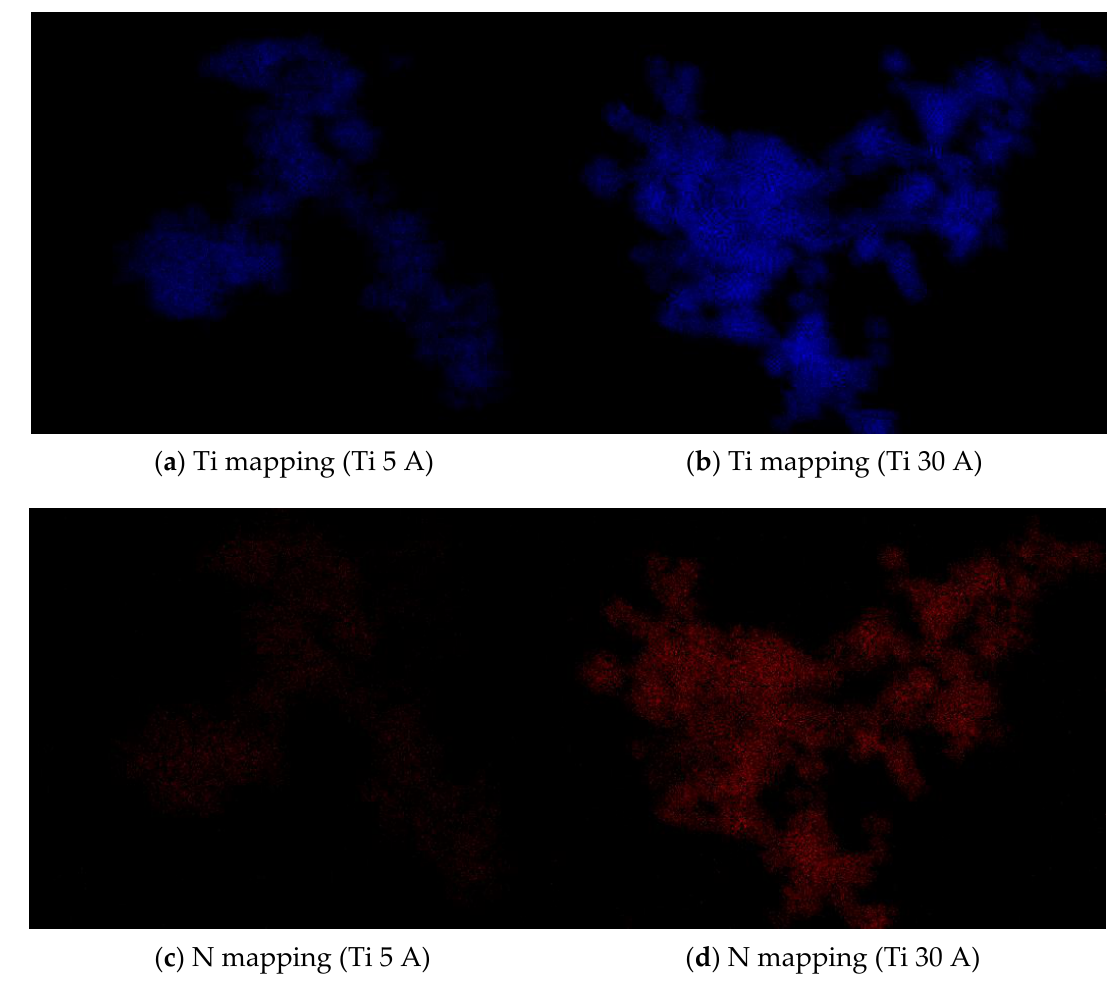
Figure 3. FE-SEM (SU9000) images of the prepared nanoparticles using ( a , b ) Ti, ( c , d ) Al, and ( e , f ) Cu electrodes at a current of 5 and 30 A. Detailed descriptions are placed below in each panel.